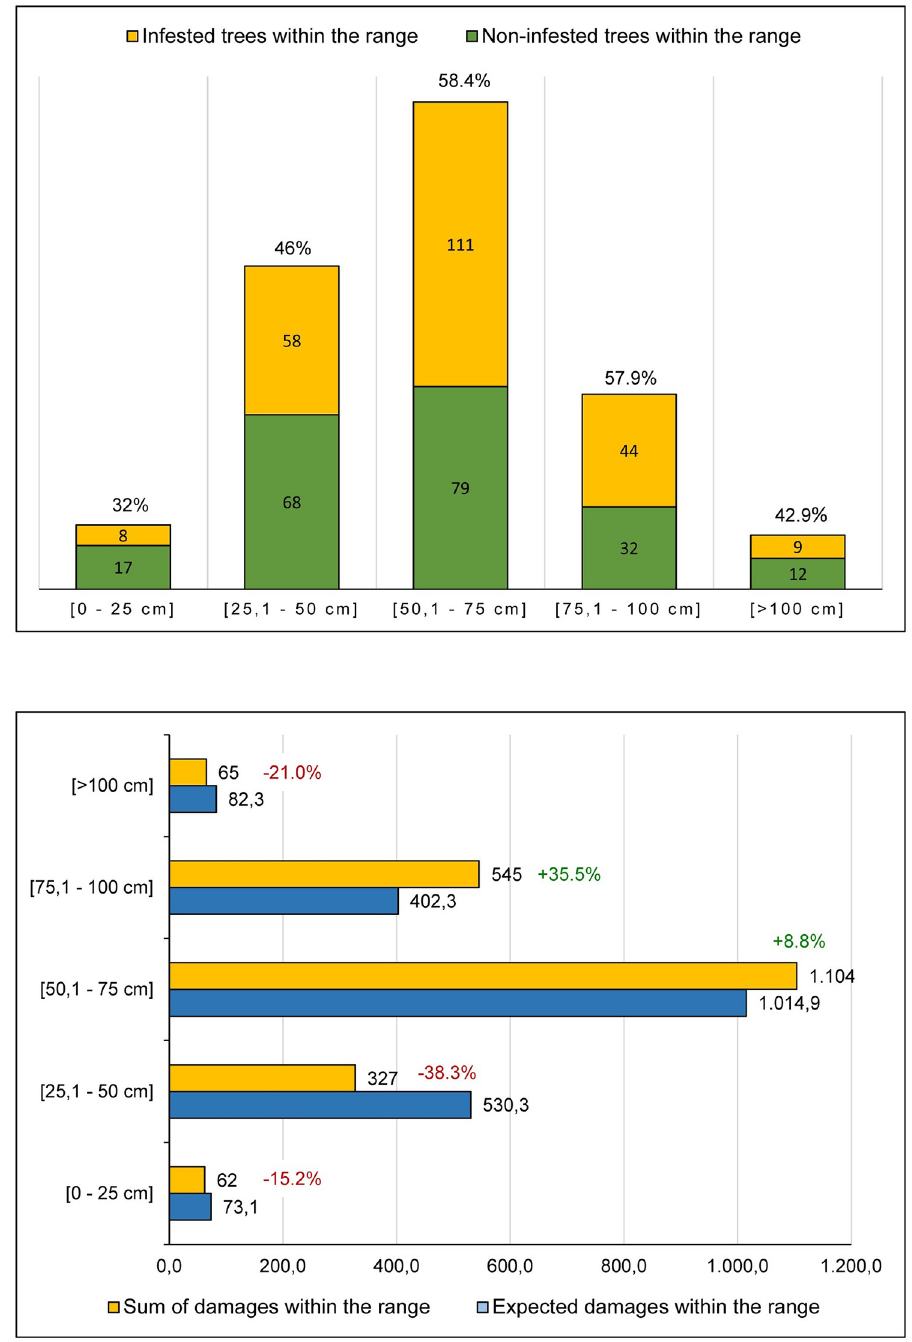
Fig 9. Tree infestation by X . chinensis based on trunk perimeter. In both graphs the 30 trees missing in December were incorporated into the counts as if they were present with the same values they had in June. The top graph shows the trees infested within each perimeter range. The bottom graph shows the sum of damages (EH+BI+GS) for all trees within their range (total damages being 2,103), and the expected damages if their distribution was neutral, i.e. with no preferences for laying on any trunk perimeter range. Percentage values in red or green tell the difference between the expected and the observed.